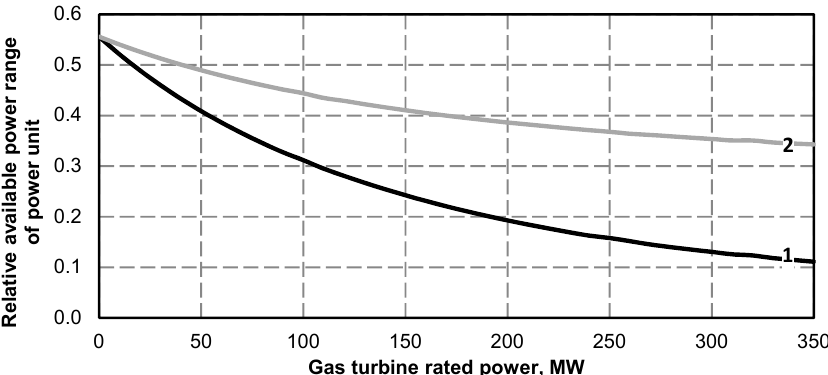
Figure 28. Relative available power range of power unit as a function of gas turbine rated power: 1–gas turbine operating at its rated power, 2–gas turbine operating with variable power ranging from 100% to 60% of its rated power.